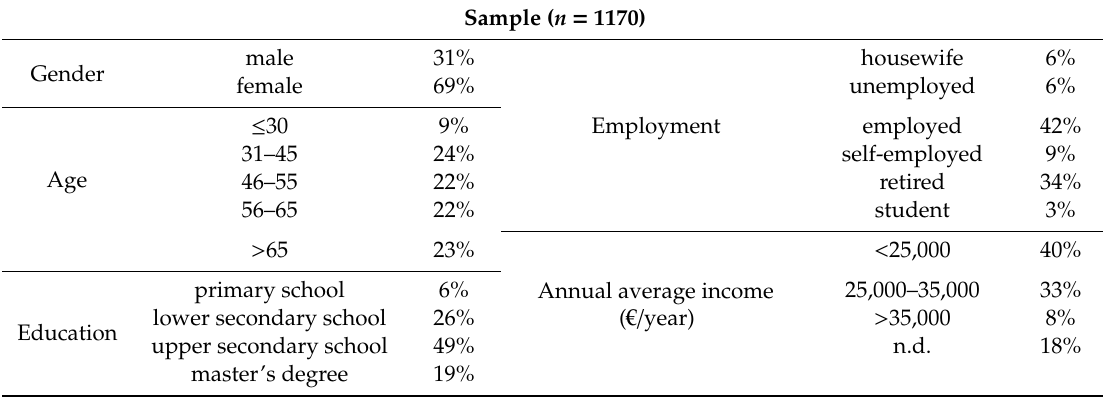
Table 3. Sociodemographic characteristics of the interviewed sample population ( n = 1170).